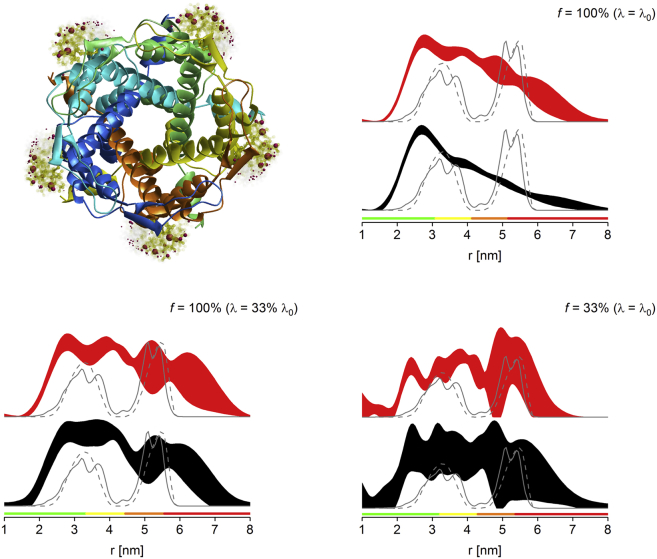
MscL M94R1 PELDOR distance distributions obtained for fully labeled protein (top right), λ-reduced fully labeled protein (bottom left, λ = 33% λ0), and sparsely labeled protein (bottom right, f = 33%). See Fig. 1 for details on the 2σ confidence intervals, predicted distance distributions, and color bars. See Supporting Material for raw PELDOR data and processing. (Top left) Shown here is the MMM model of fully labeled protein using MscL from M. tuberculosis (label modeled onto residue F88). To see this figure in color, go online.